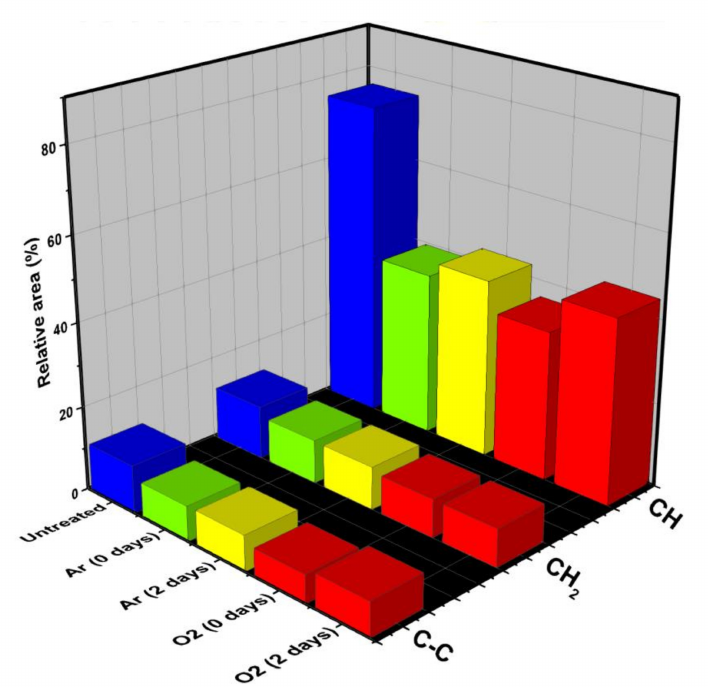
Figure 7. Relative percentages of regions of the main